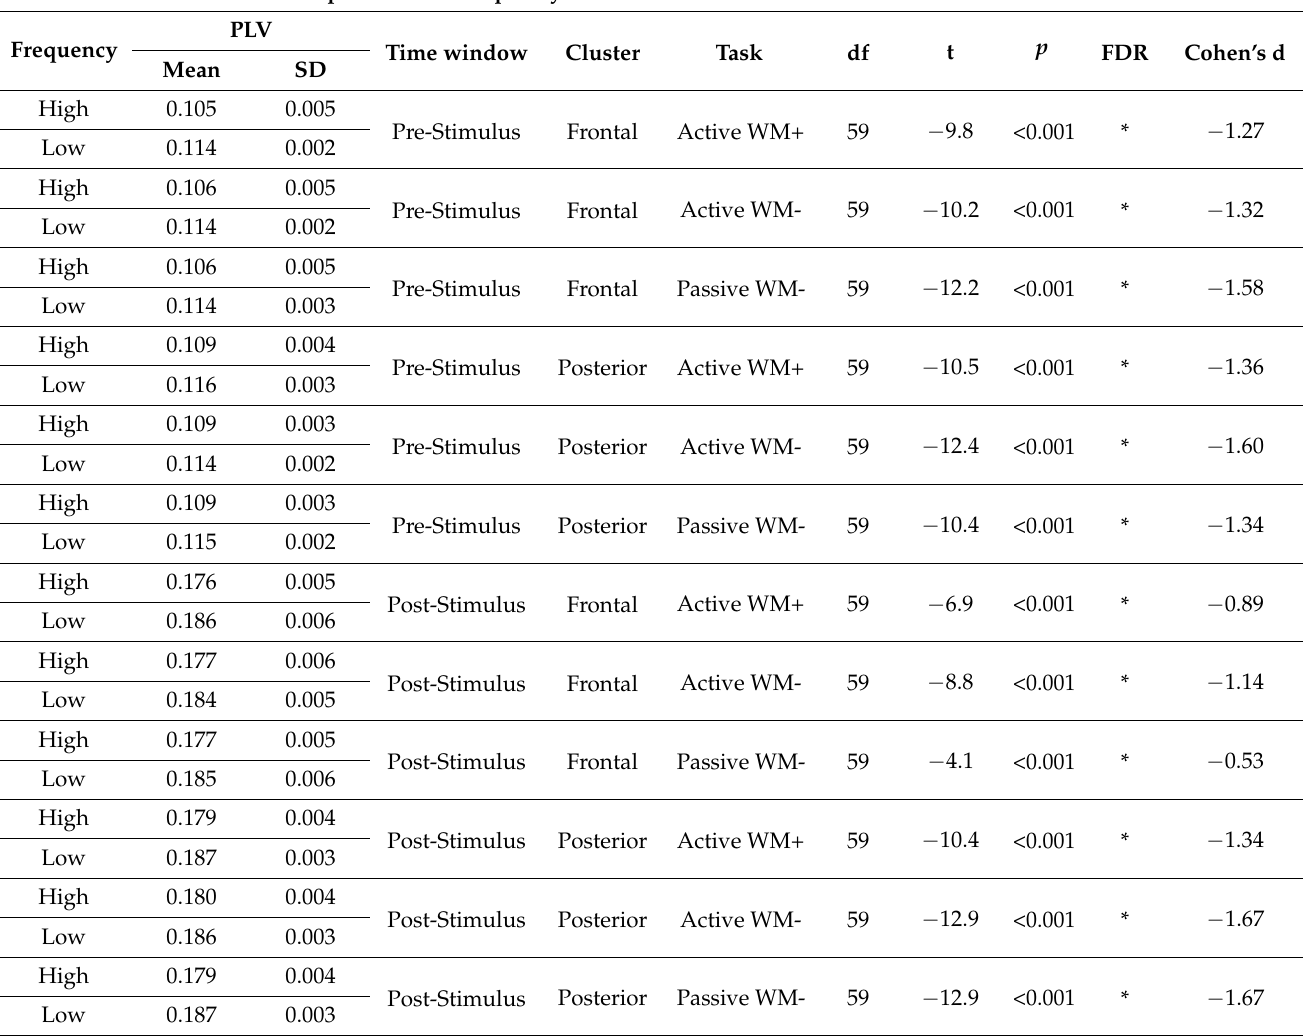
Table 4. A summary of all pairwise comparisons for the two frequency bands. An FDR correction was applied across comparisons. Significance after the FDR correction is denoted in the corresponding column of the table. When marking significance, * denotes significance after FDR